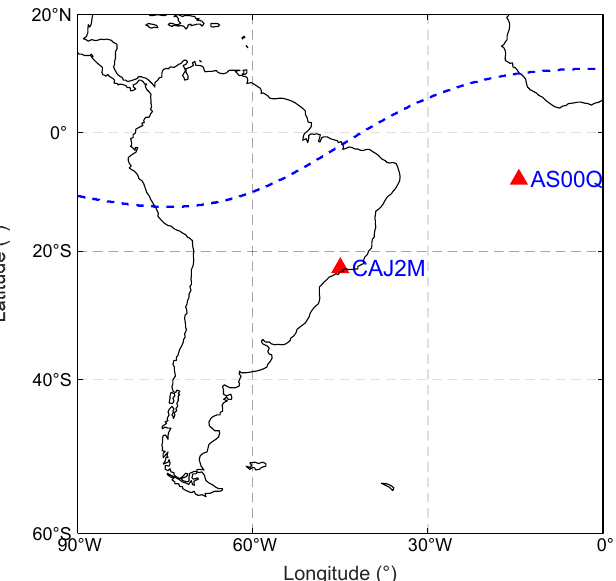
Figure 1. Distribution of ionosonde stations. The red triangles indicate the positions of ionosondes, and the blue dashed line marks the geomagnetic equator.